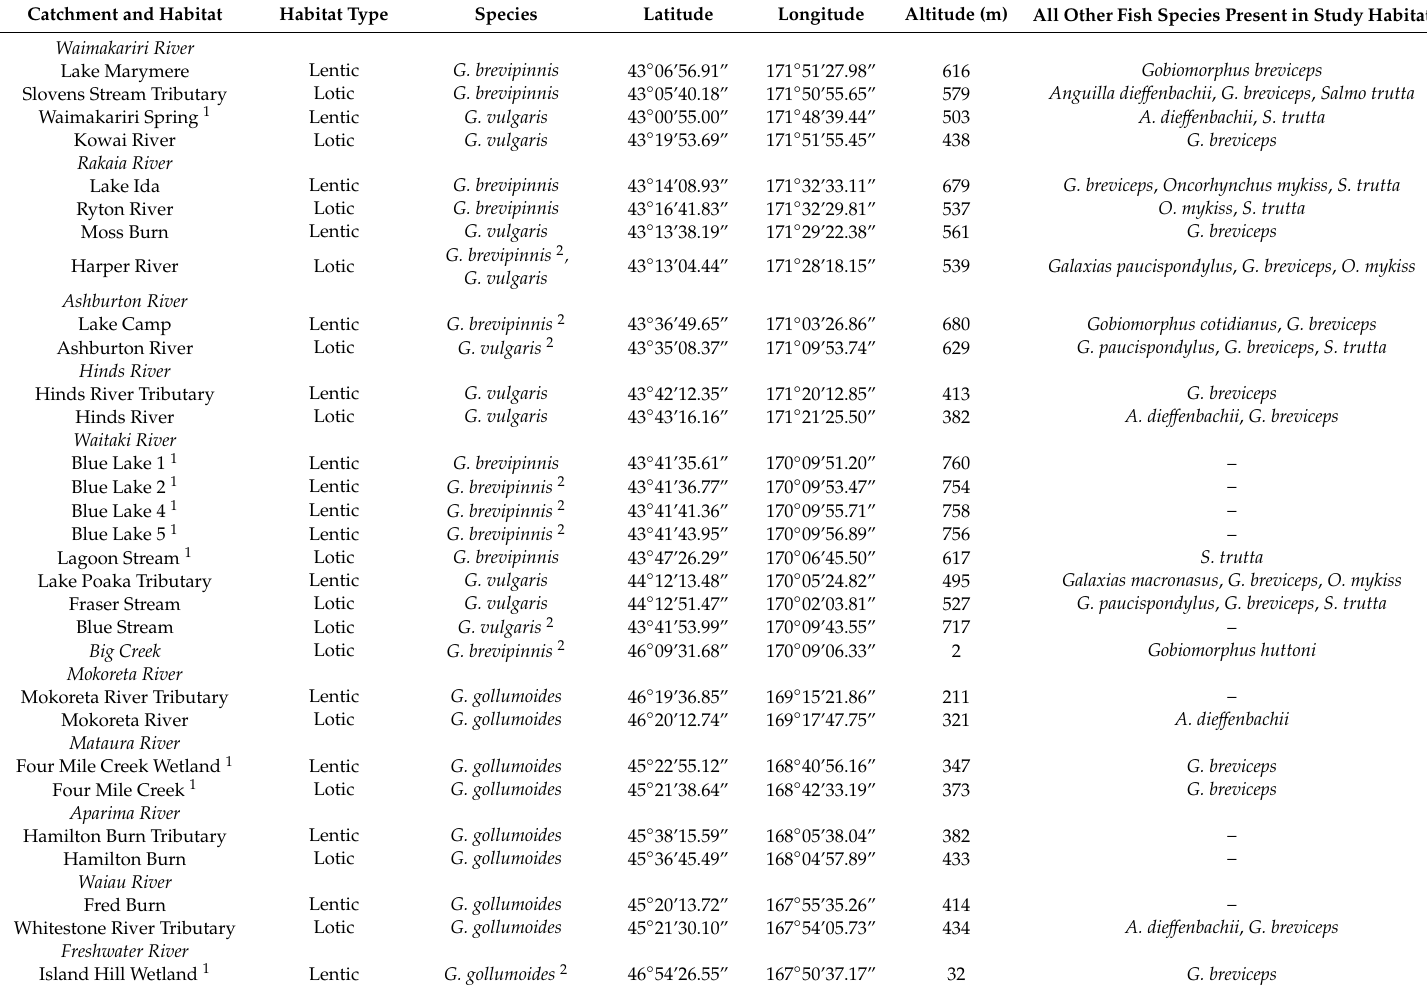
Table 1. Location of study habitats within river catchments (in italics), habitat type (lentic or lotic), Galaxias species collected and all other fish species present. 1 habitat name not gazetted by the New Zealand Geographic Board, but locally recognised. 2 unpaired habitat. – no other fish species